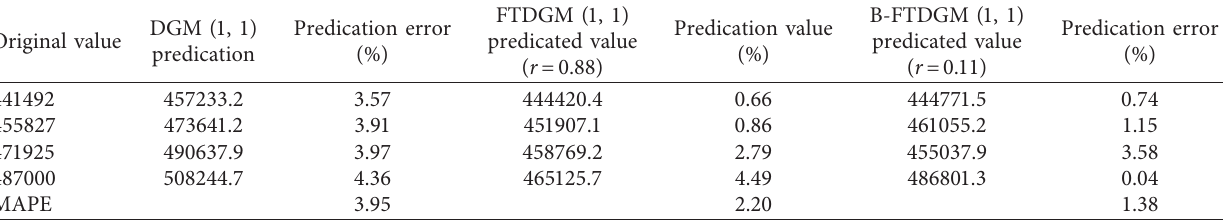
Table 2: Results from different grey predication models.